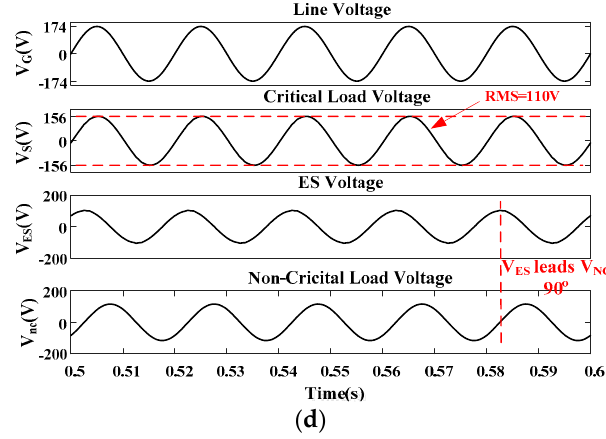
Figure 6. The simulation waveforms based on the dead-beat and δ control under the ideal grid conditions and pure reactive power compensation mode. ( a ) Three operating modes at full time ranges; ( b ) Capacitive mode @VG = 102 V; ( c ) Resistive mode @ VG =115 V; ( d ) Inductive mode @ VG = 123 V.